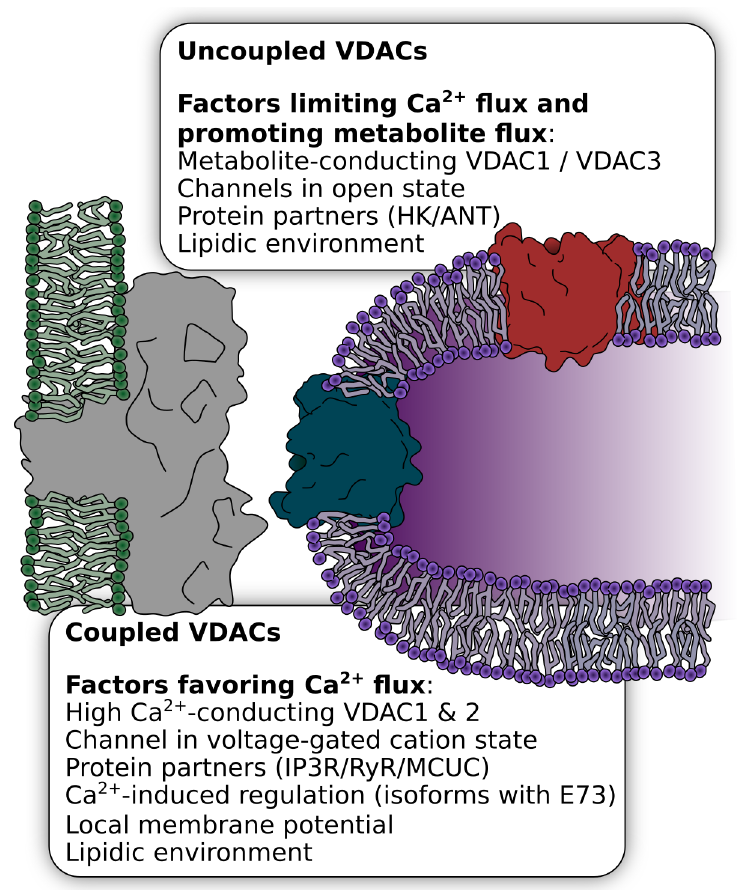
Figure 3. Regulation of VDAC by subcellular localization. A fraction of VDAC channels was shown to be present in couplons with Ca 2+ release channels of the ER/SR, in particular VDAC1 with the IP3R or VDAC2 with the RyR. These couplons represent hotspots of Ca 2+ -mediated regulation of mitochondrial activity. In addition to the strategic positioning of VDAC in close vicinity to the mouth of the release channels, other factors might regulate VDAC within and outside the couplons for the specialized tasks within these environments. These include isoform selectivity, protein partners, the lipidic environment, and the voltage-gated state of the channel. Depending on the VDAC localization, these factors might determine whether VDAC serves as a Ca 2+ or metabolite channel.